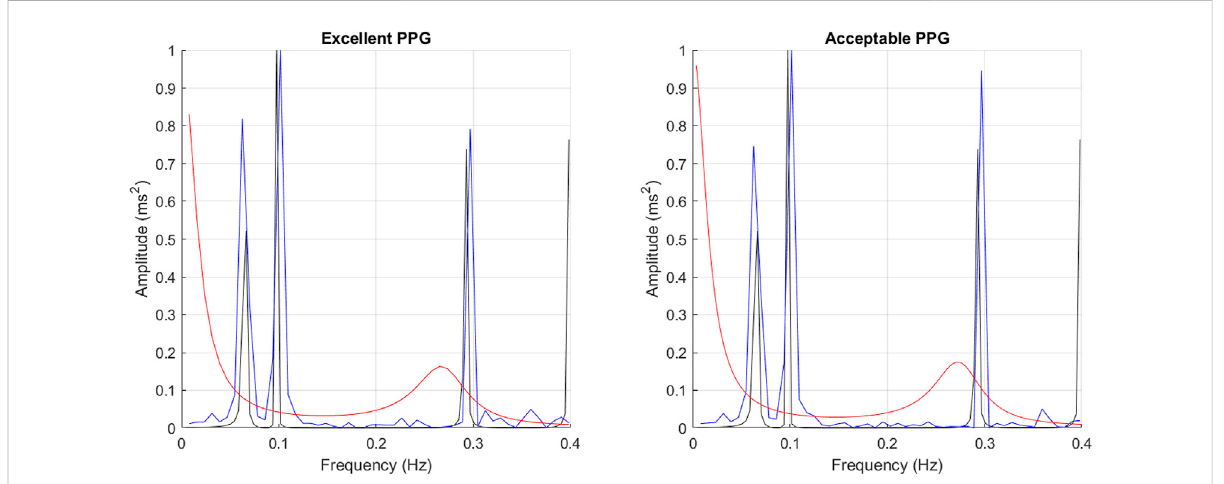
FIGURE 8 Example of spectra obtained from gold standard PRV (black), FFT (blue) and PMUSIC (red), both from excellent and acceptable quality PPG